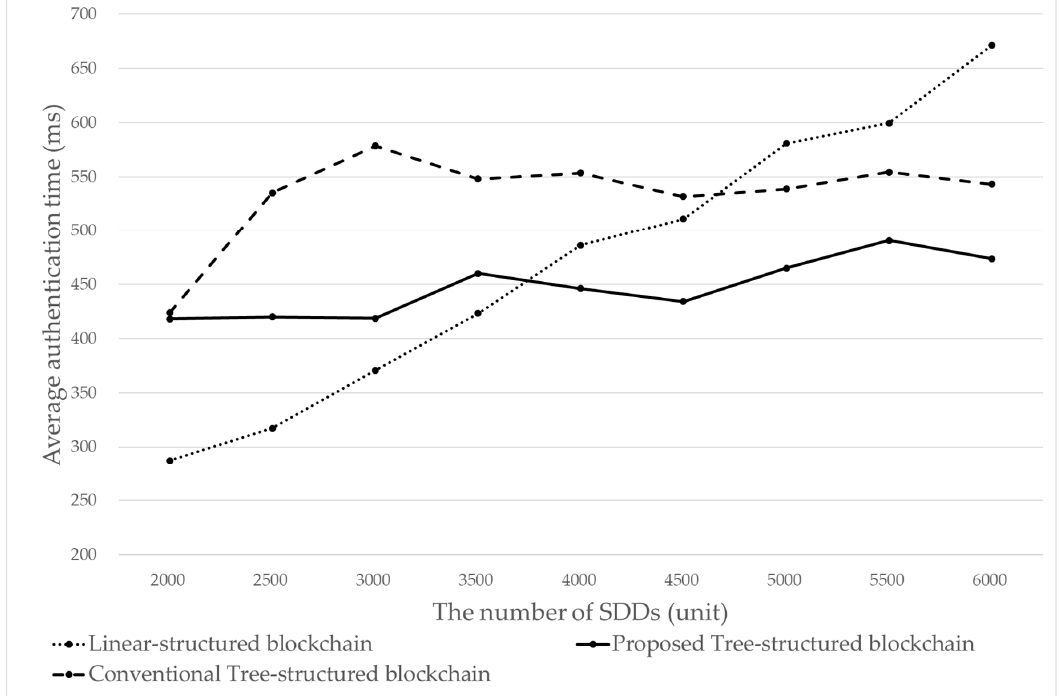
Figure 12. The average authentication time per